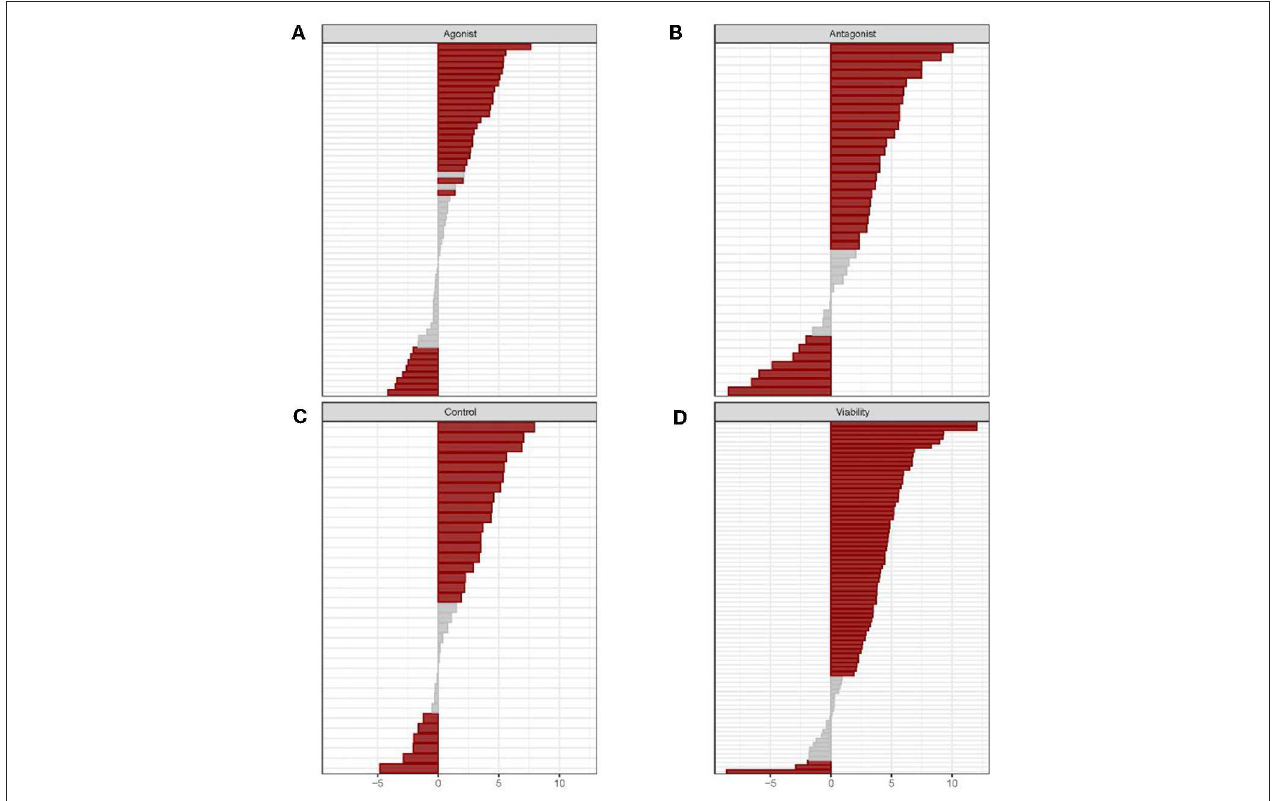
FIGURE 1 | Individual assay responses of drugs and ENVCs grouped by readout type: (A) agonist, (B) antagonist, (C) control, and (D) viability. For each assay readout, the activities of drugs and ENVCs were compared using the χ 2 -test. Hit rate differences were determined by subtracting the ENVC hit rate from the drug hit rate. A p -value was calculated to determine the statistical significance of the hit rate difference. Assays marked in red signifies significant ( p > 0.05) and gray otherwise.